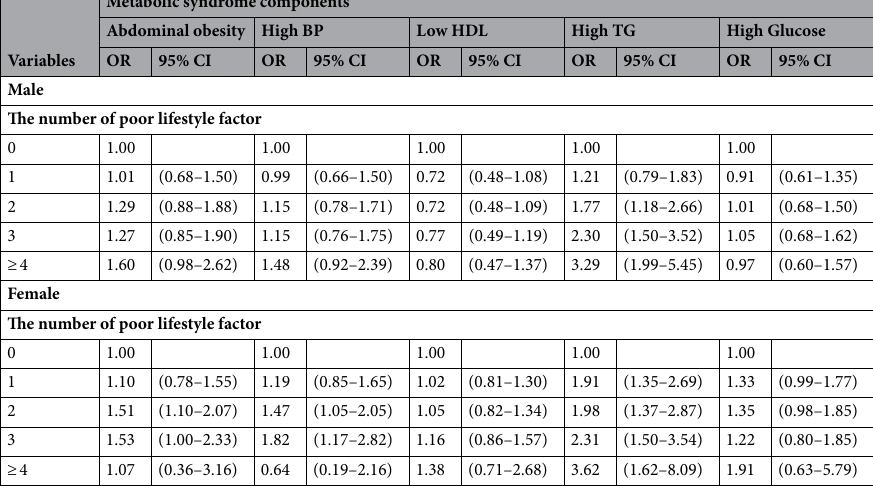
Table 3. The results of subgroup analysis stratified by metabolic syndrome. * Adjusted for other covariates.